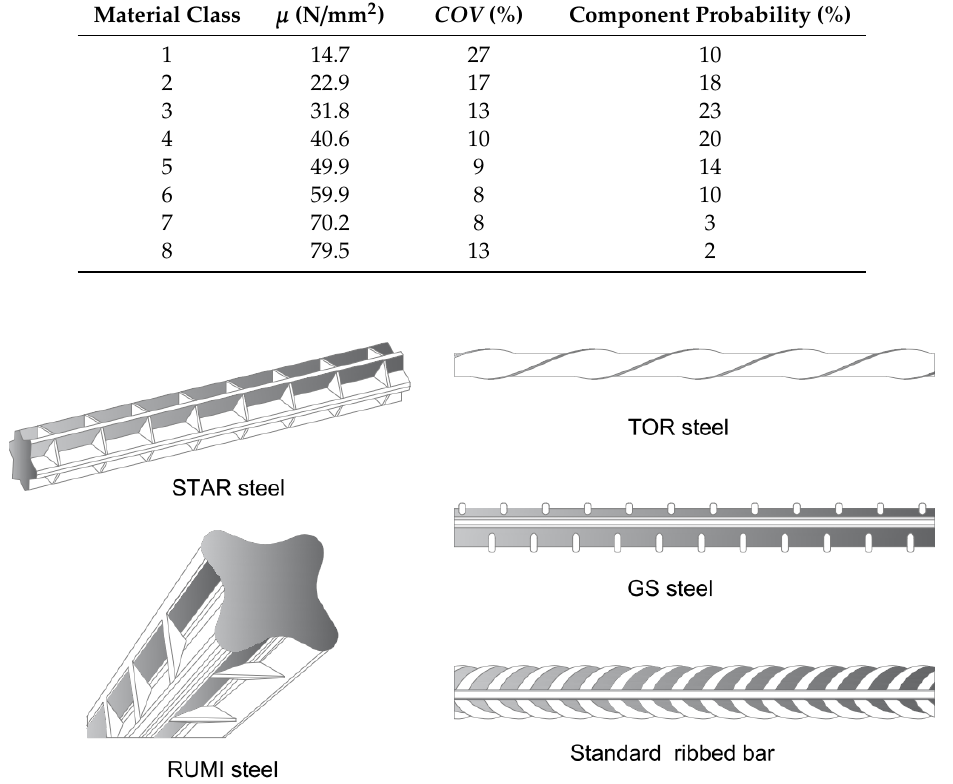
Figure 2. Steel ribbed bar typologies commonly used in Italy during the 1960s.